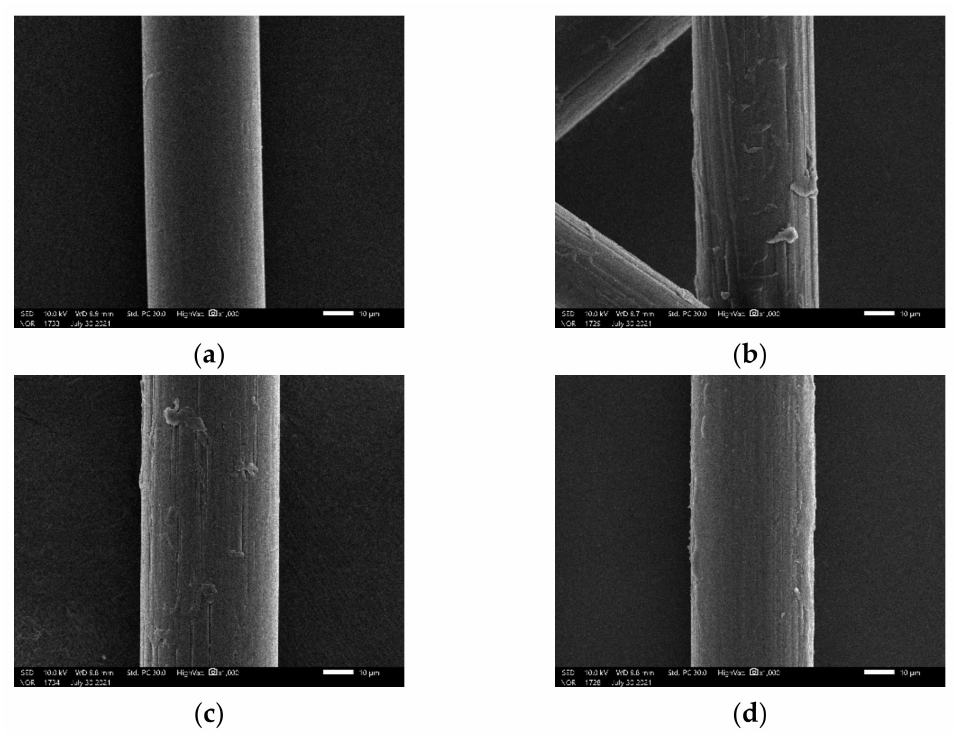
Figure 12. Surface morphology PVA fibers of unmodified ( a ) and NaOH modified ( b ), HCl modified ( c ), KH550 ( d )